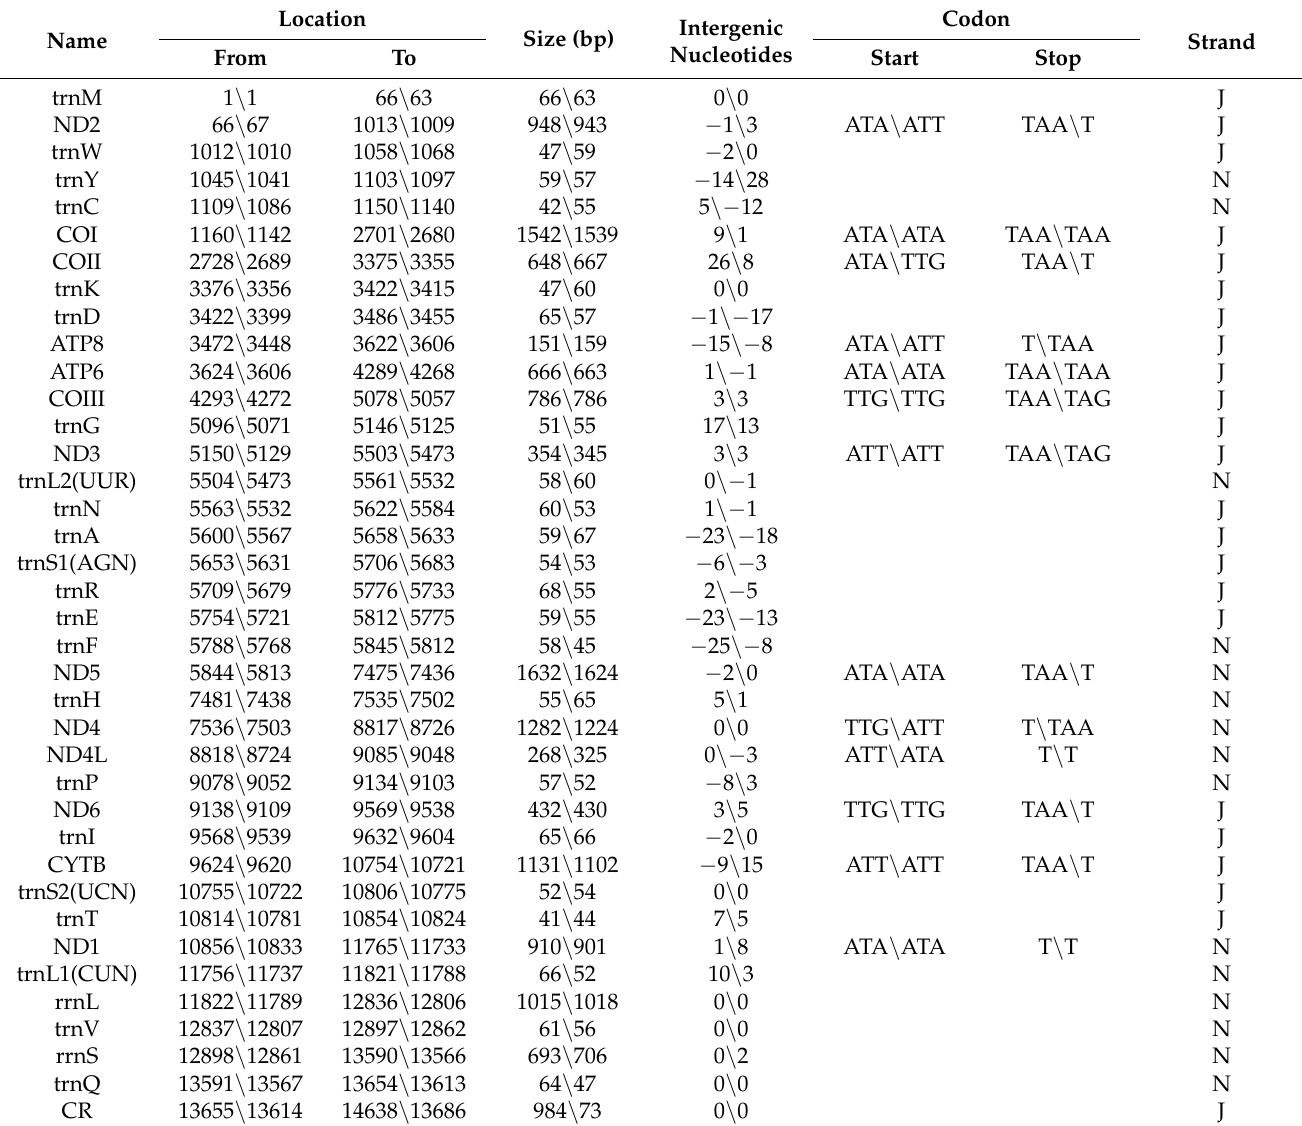
Table 3. Mitochondrial composition of the L. shansia (on the left) and L. Singoriensis (on the